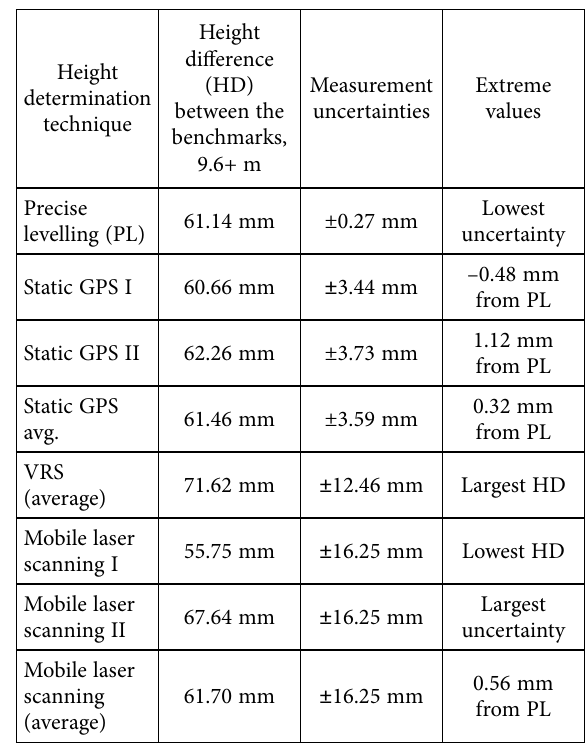
Table 9. Final results of the field